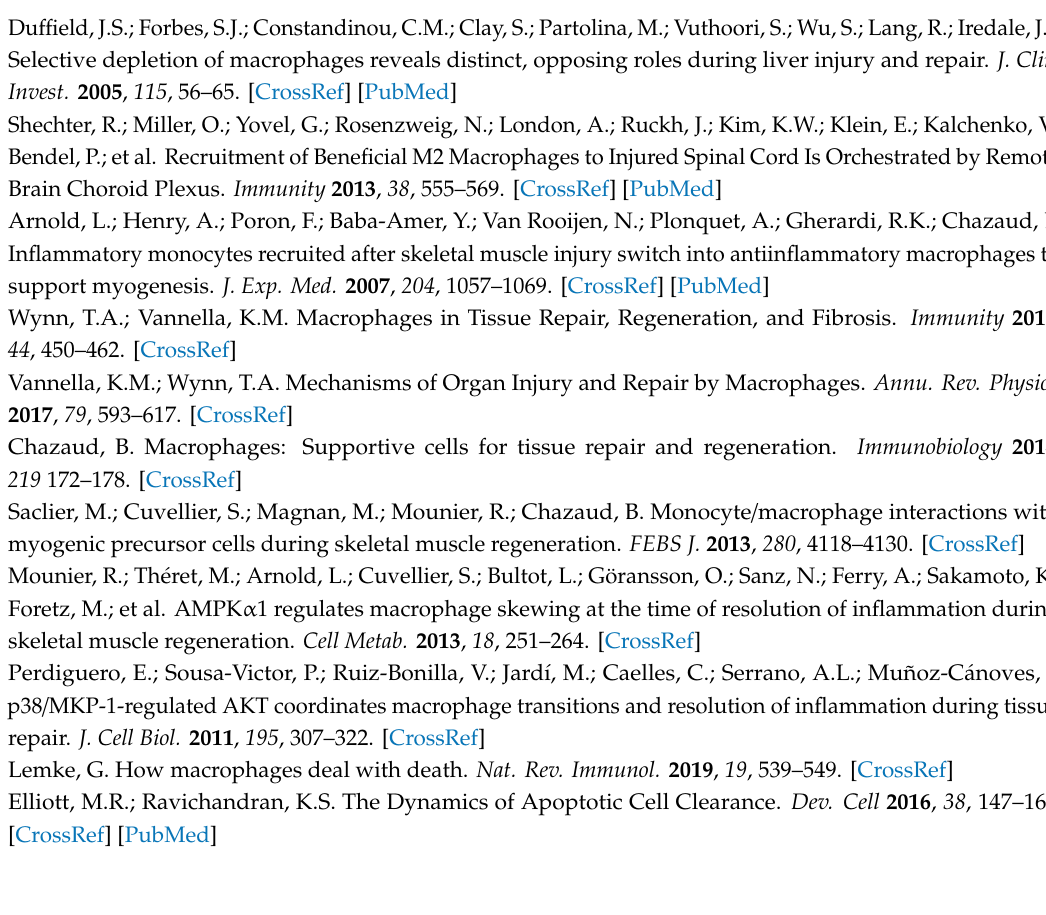
Figure S1 : Gating strategy to isolate MPs from CTX-injured muscles. Figure S2: Characterization of the LysM CRE :Nfix fl / fl mice. Figure S3: CSA quantification, NT and MPs infiltration in Nfix fl / fl and LysM CRE :Nfix fl / fl mice after CTX injury and Nfix silencing in WT BMDM. Figure S4: In vitro proliferation and di ff erentiation